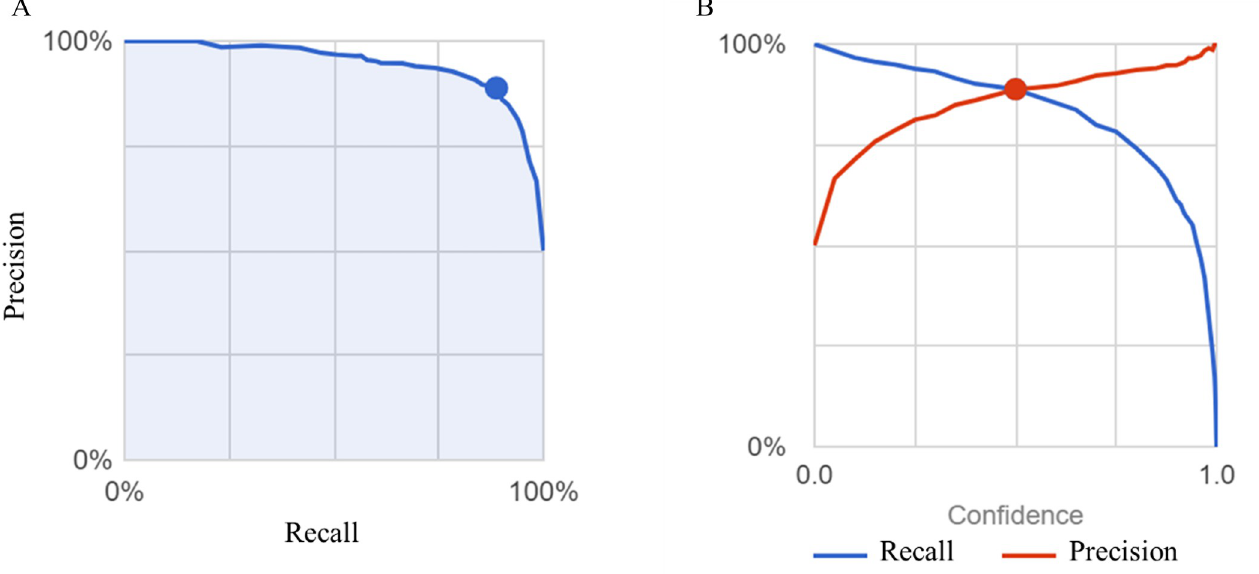
Fig 1. (A) The precision of the Groups I and N colon image AI model is plotted as a function of recall. The blue shaded area represents the area under the curve (AUC), and the blue dot indicates the value in the case with a reliability threshold of 0.5. (B) The intersection of the recall (blue line) and the precision (red line) is shown. The blue and red dots indicate the values when the reliability threshold is set to 0.5.